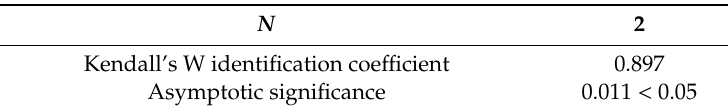
Table 3. Verification statistics of